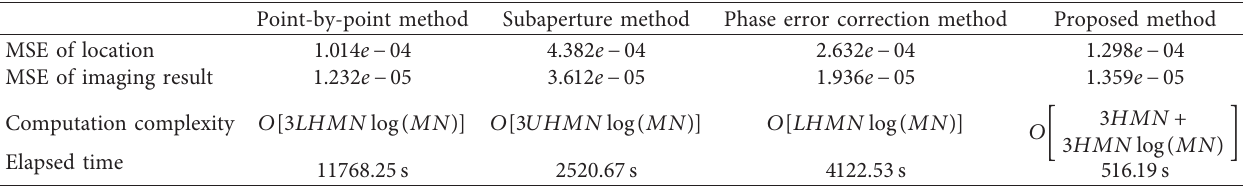
Figure 8: OMP reconstruction results with different location estimation methods. (a) The target model. (b) The result with ideal parameters. (c) The result with point-by-point method estimated parameters. (d) The result with subaperture method estimated parameters. (e) The result with phase error correction method estimated parameters. (f) The result with proposed method estimated parameters. Table 1: Performance comparison of four